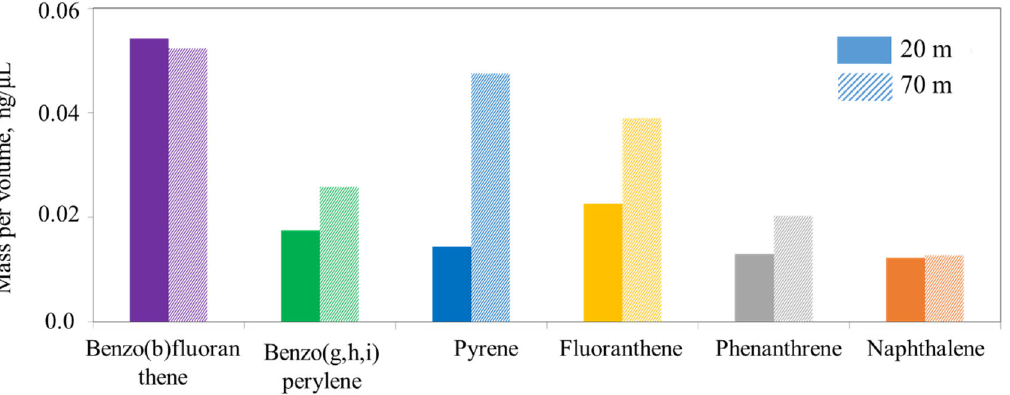
Figure 7. The distribution of chemical components of PM samples in the environment, collected at point 20 m and 70 m away from the roadside, respectively.